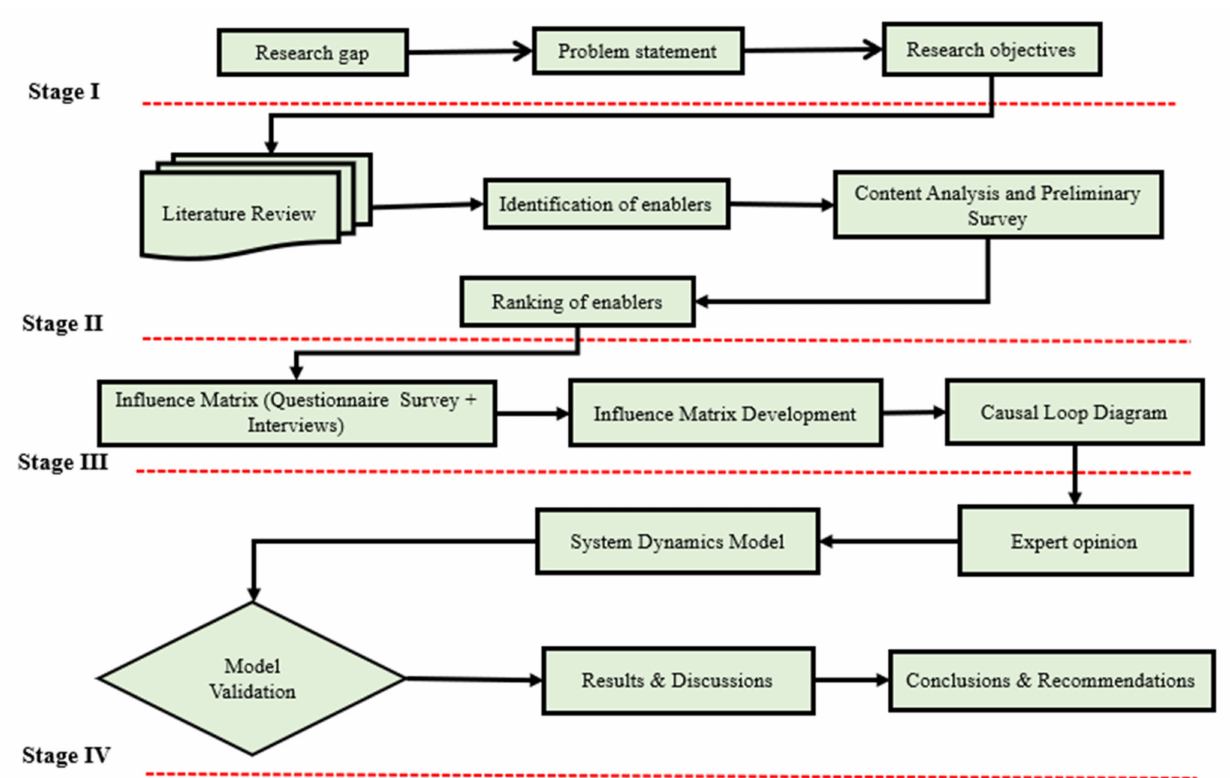
Figure 1. Research Methodology